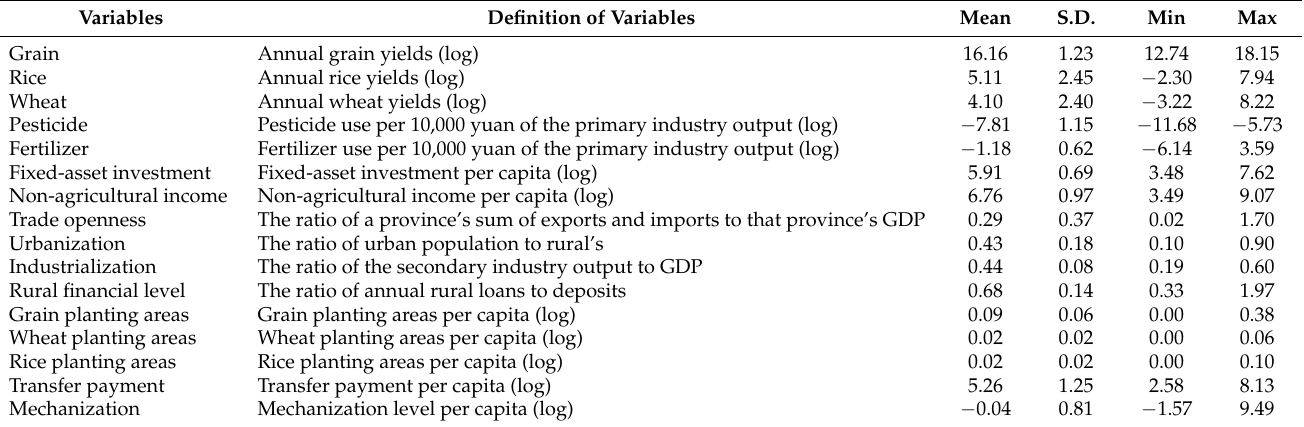
Table 2. Descriptive statistics of variables.